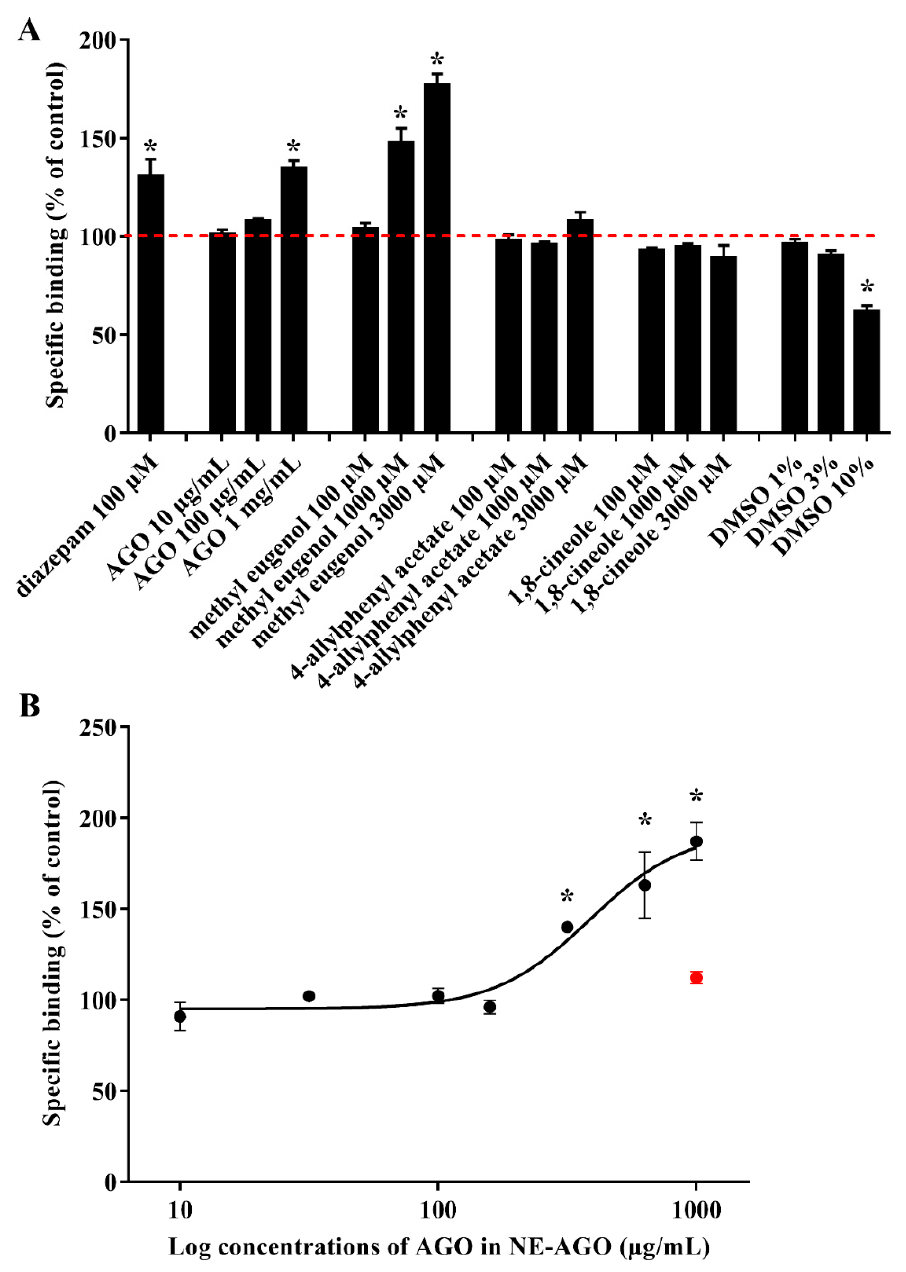
Figure 3. ( A ) Modulation of [ 3 H]muscimol binding to rat brain cortical homogenate. The 100% binding (dashed red line) denotes the total specific binding by 30 nM [ 3 H]muscimol. ( B ) Concentration-dependent modulation by 20% NE-AGO. Data are presented as mean percentages of specific binding ± SEM. Red point indicates the blank nanoemulsion at the highest concentration. Asterisk (*) indicates significant differences between groups with 100% binding ( p < 0.05).